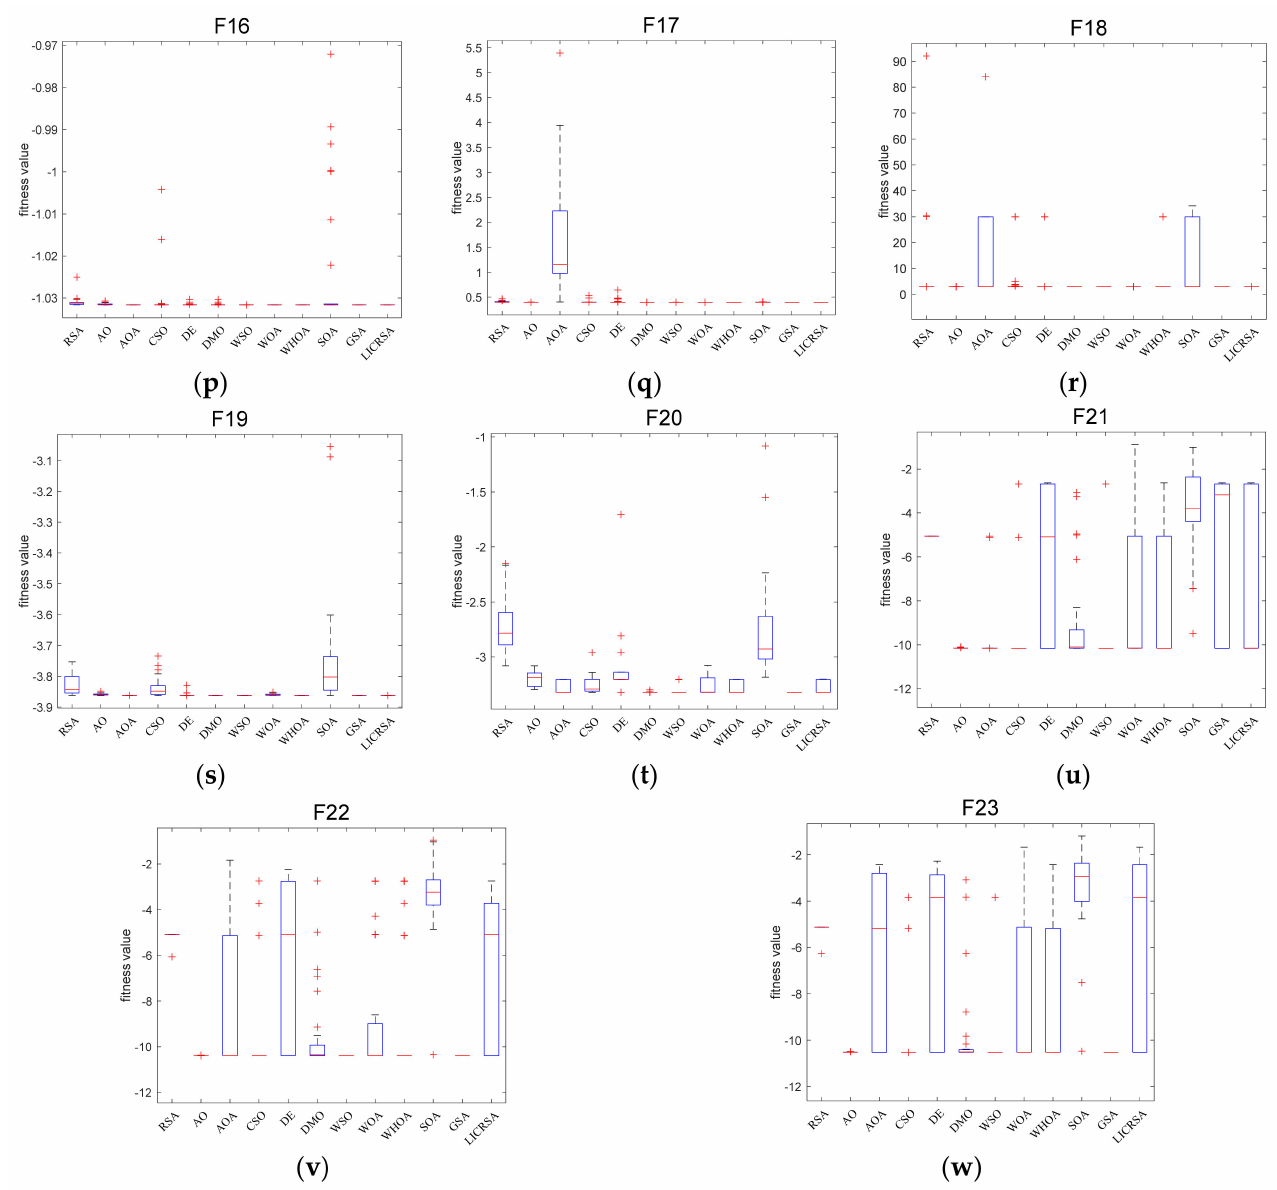
Figure 8. Box plot of LICRSA and RSA, AO, AOA, CSO, DMO, DE, WSO, SOA, GSA, WHOA, WOA: